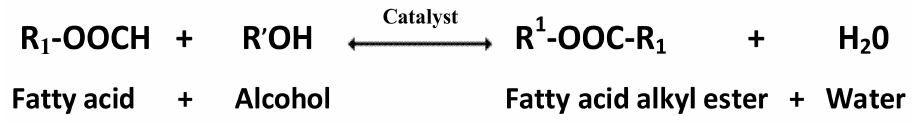
Figure 6. Esterification reaction [157].